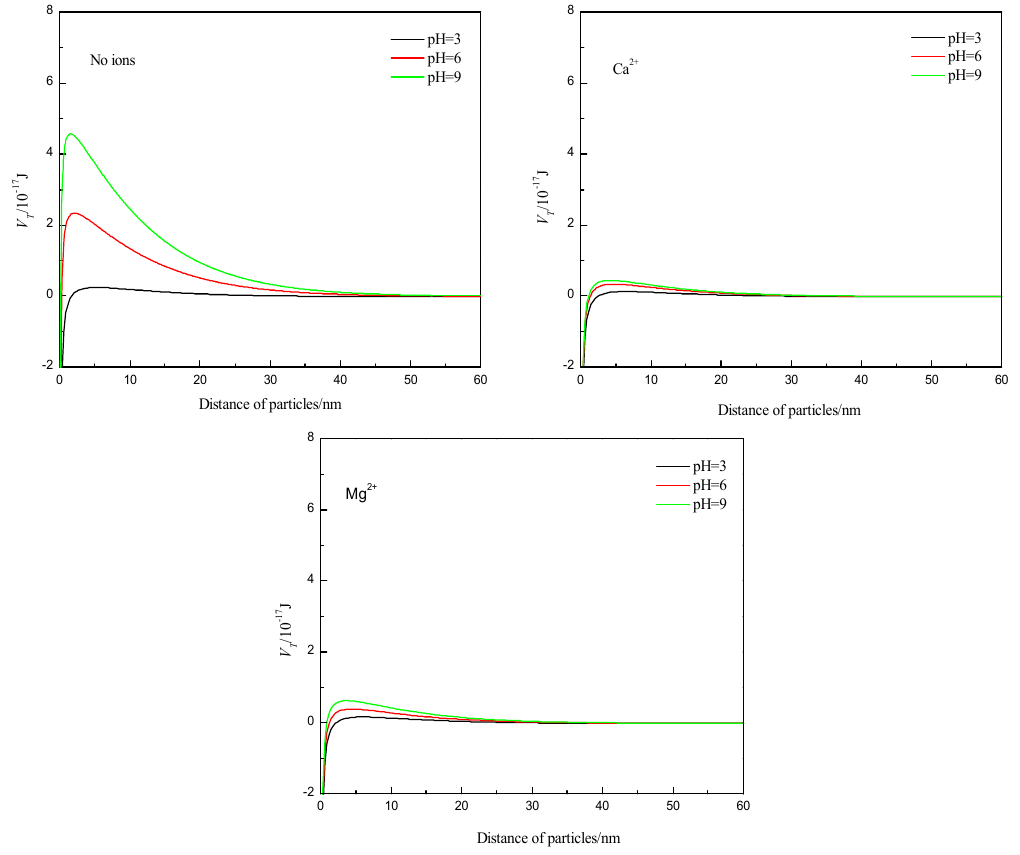
Figure 5. Total interaction energy of particles at different pH values without and with Ca 2+ , Mg 2+ .